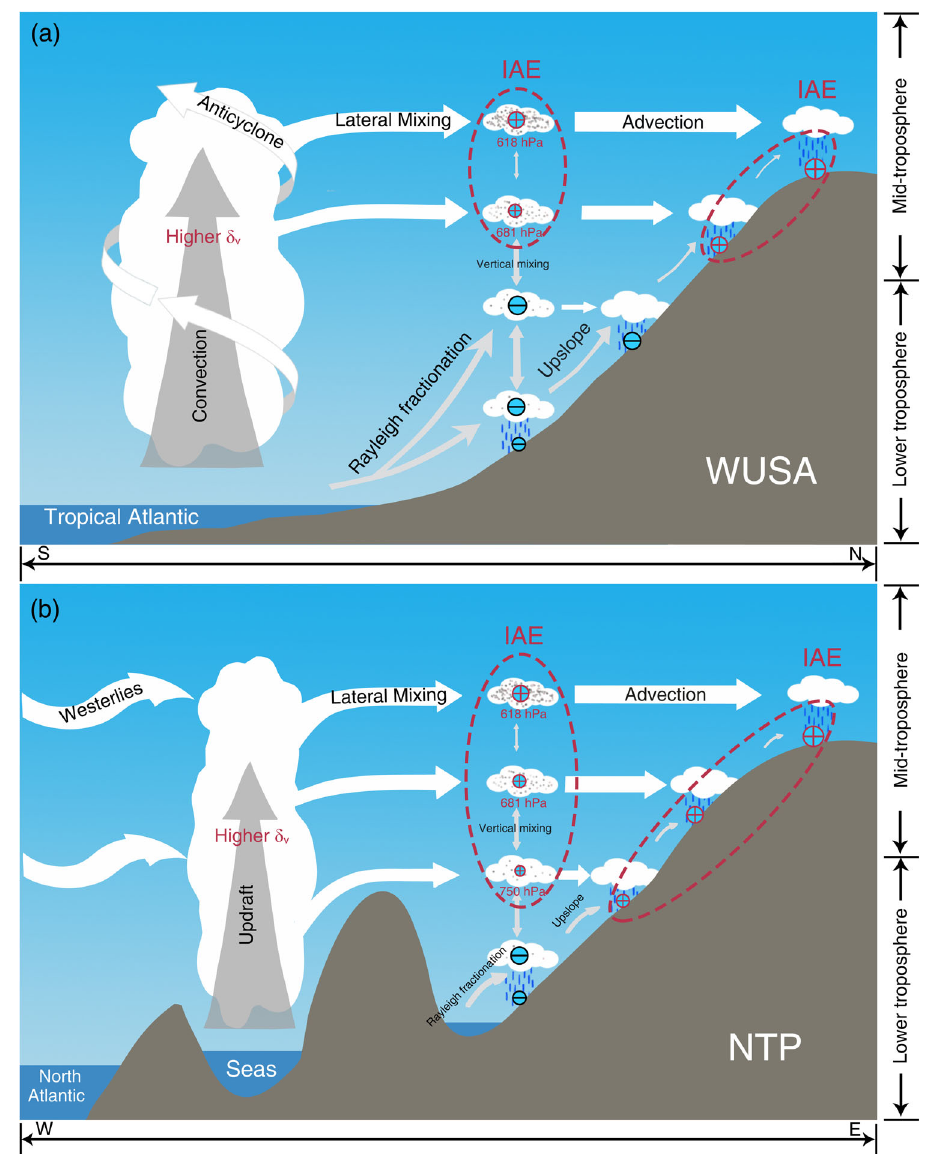
Fig. 4 | Schematic diagrams of the mechanisms that cause the IAE during summer from an atmospheric circulation perspective. a WUSA, western United States of America. b NTP, northern Tibetan Plateau. Note the plus (minus) signs within the circles indicate the inverse altitude effect (altitude effect), and the sizes of the circles represent the strength of the IAE (AE), i.e., larger circles represent a more pronounced IAE (AE). The white arrows indicate the moisture contributions from the mid-troposphere (above 825hPa) to the target region. The gray arrows